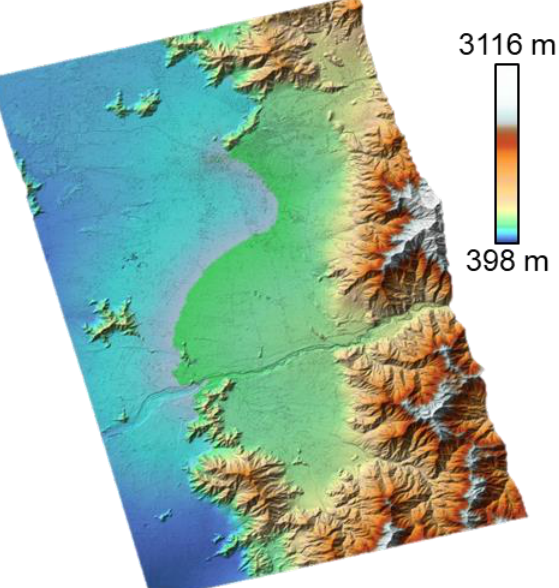
Figure 4. Change Raw DEM of the Santiago de Chile area calibrated to the edited TanDEM-X